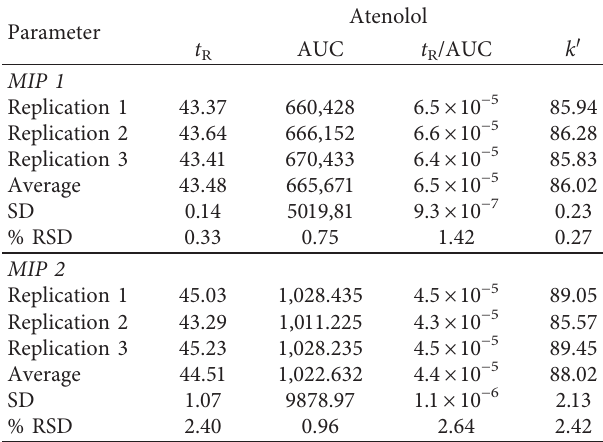
Table 11: Intercolumn reproducibility of the imprinted monolithic